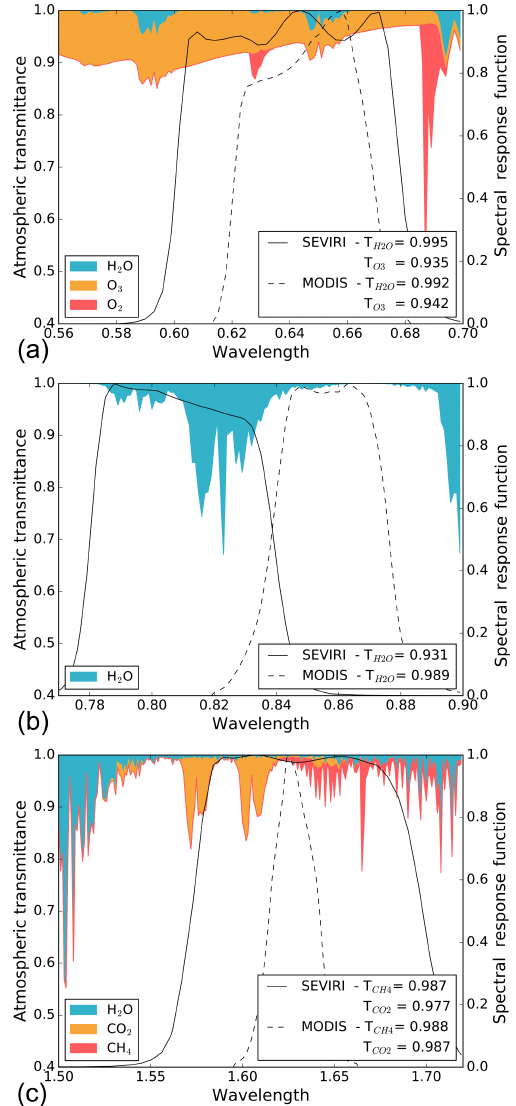
Figure 3. Spectral response function of the SEVIRI bands at 0.64 (a) , 0.81 (b) and 1.64µm (c) with the corresponding MODIS ones (dashed lines) as well as the atmospheric transmittance within the spectral range (in colour). The transmittances have been calcu- lated with the SOCRATES radiative transfer scheme (Manners et al., 2015; Edwards and Slingo, 1996) assuming a humidity profile measured during SAFARI (Keil and Haywood, 2003). In the legend of each plot, the transmittance weighted by the spectral response function is given for the main absorbing